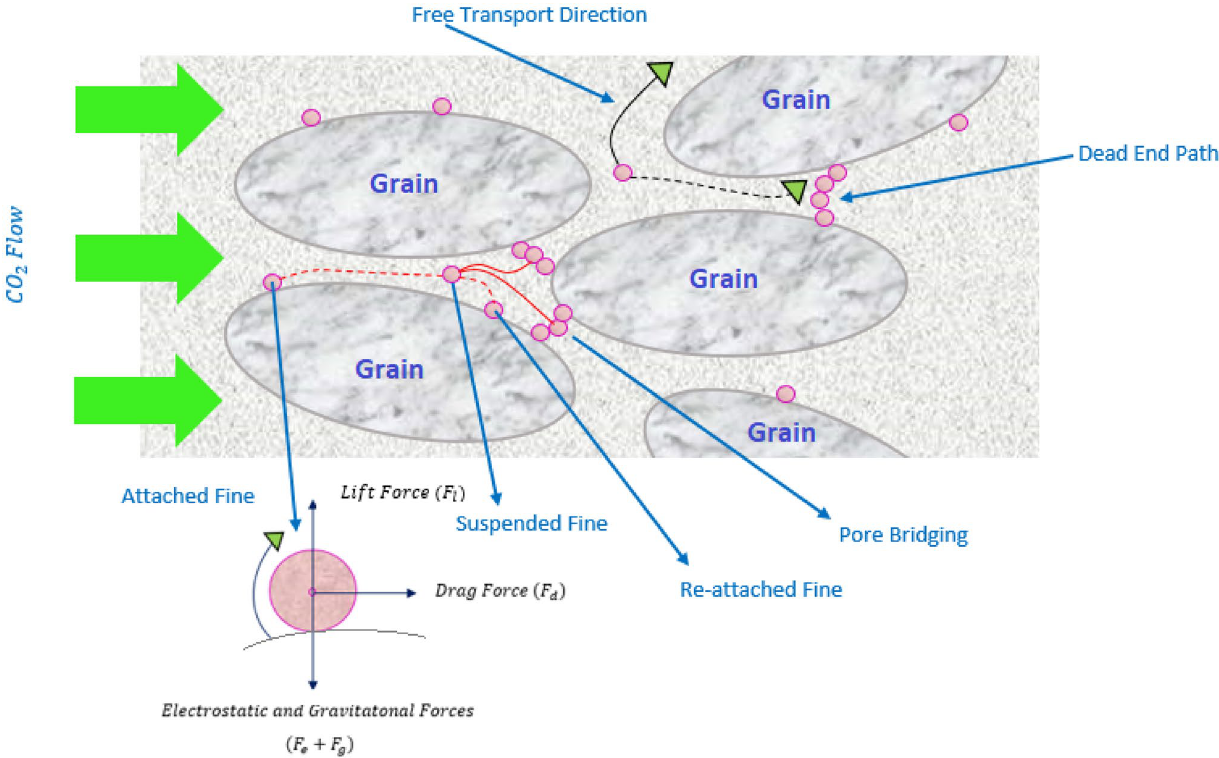
Fig. 1 Schematic diagram of fines behavior in carbonate porous media during CO